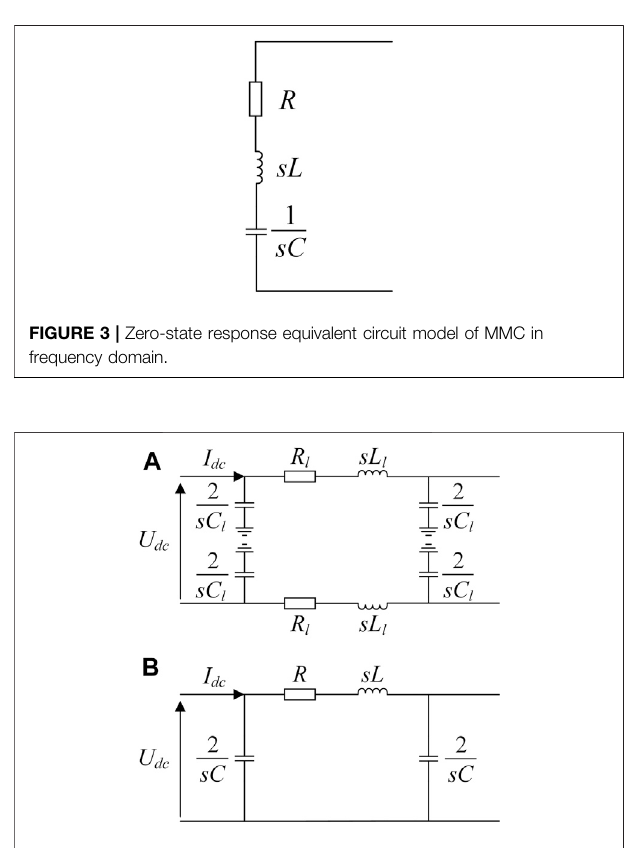
FIGURE 4 | Equivalent circuit model before and after conversion of DC line (A) Before conversion. (B) After